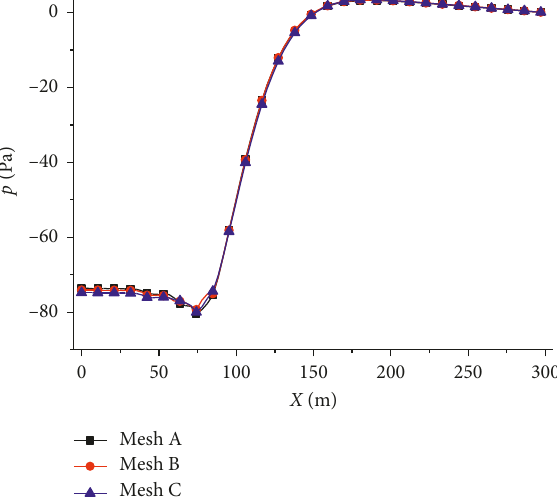
Figure 4: Static pressure profiles at different positions at X -axis for different mesh sizes.